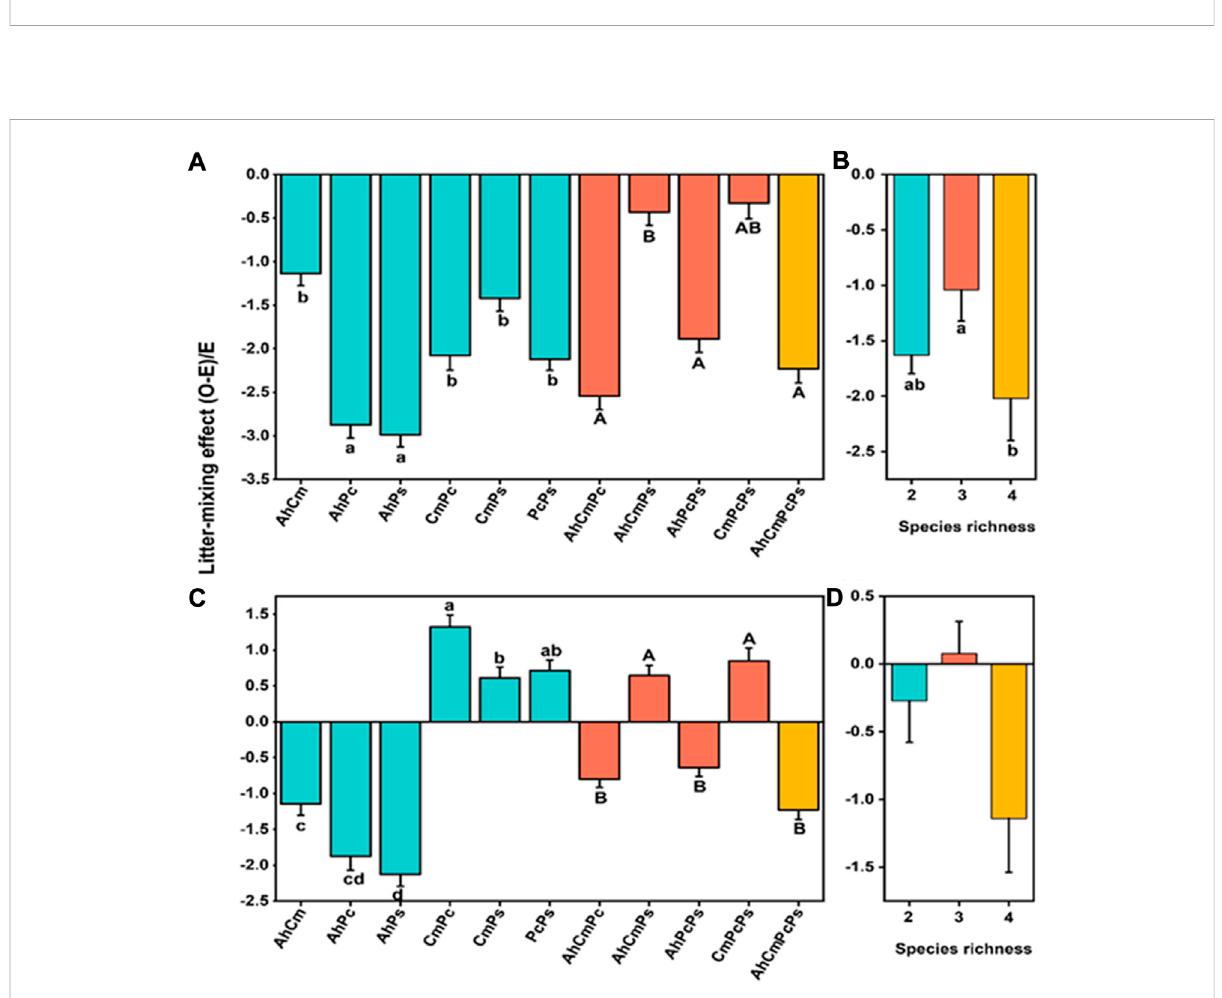
FIGURE 5 Litter-mixingeffects(LME)oncumulativeCO 2 emissionduring (A,B) theEarlystage (C,D) theLatestagefortwo,threeandfourspeciesmixtures. All means are ±SE, 5 replicates per treatment. Lowercase letters indicate the difference in two litter species; Capital letters indicate the difference of three and four litter species mixture (ANOVA followed by LSD test, p <